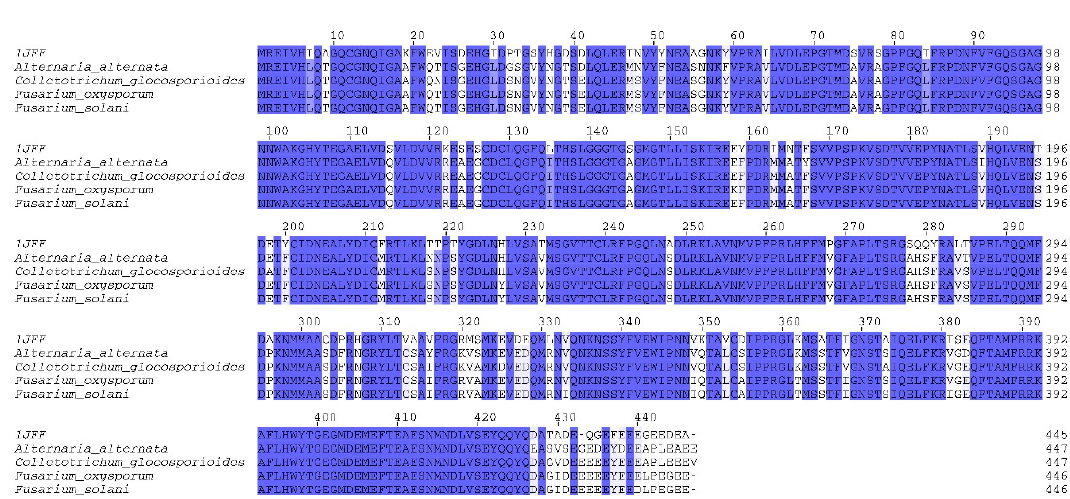
Figure 1. Alignment of the peptide sequence from the four fungal species with the template sequence of β -tubulin (1JFF) obtained from the PubChem. Highly conserved regions are indicated in blue.